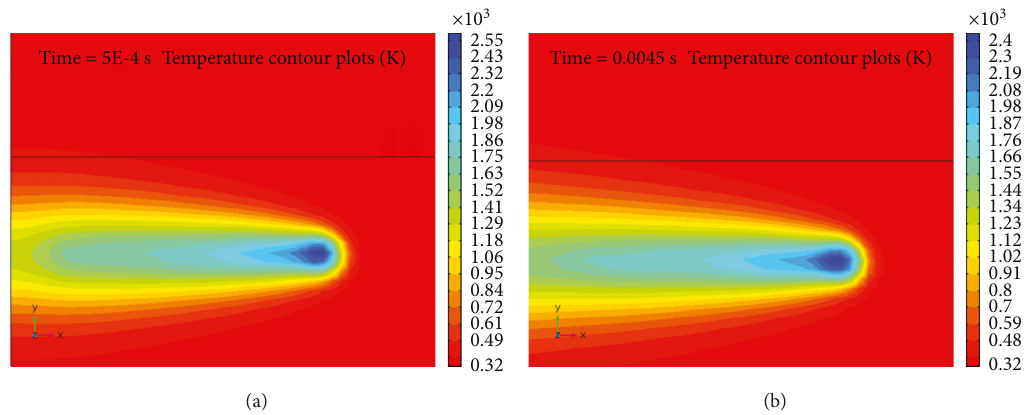
Figure 6: Temperature contour plots during the multitrack depositing process when laser irradiates the points P1 and